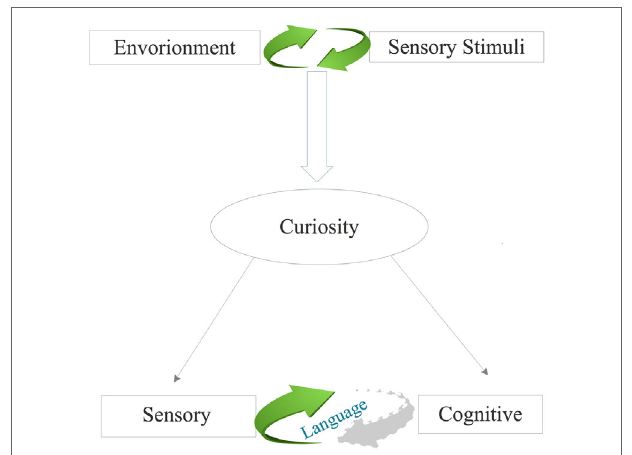
FiGUre 3 | Illustrate the connection between language